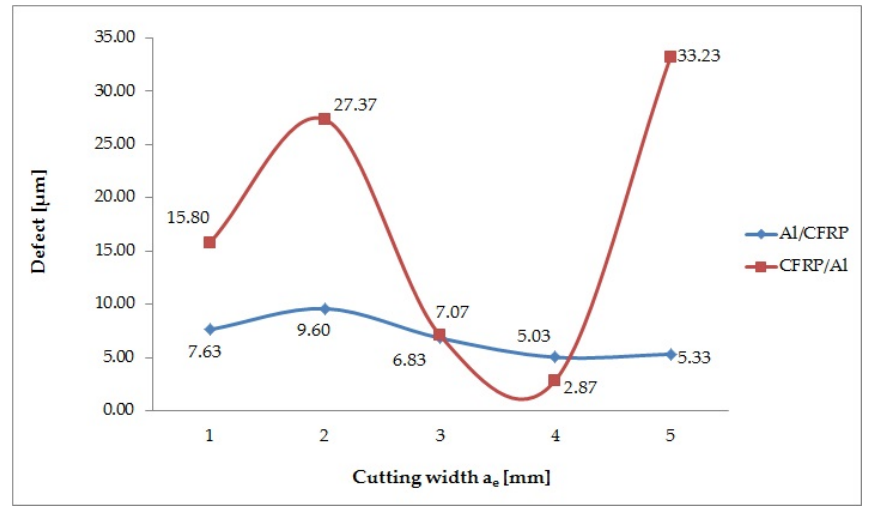
ff ect of cutting width change on value of Figure 13. Effect of cutting width change on value of defect. Figure 13. E